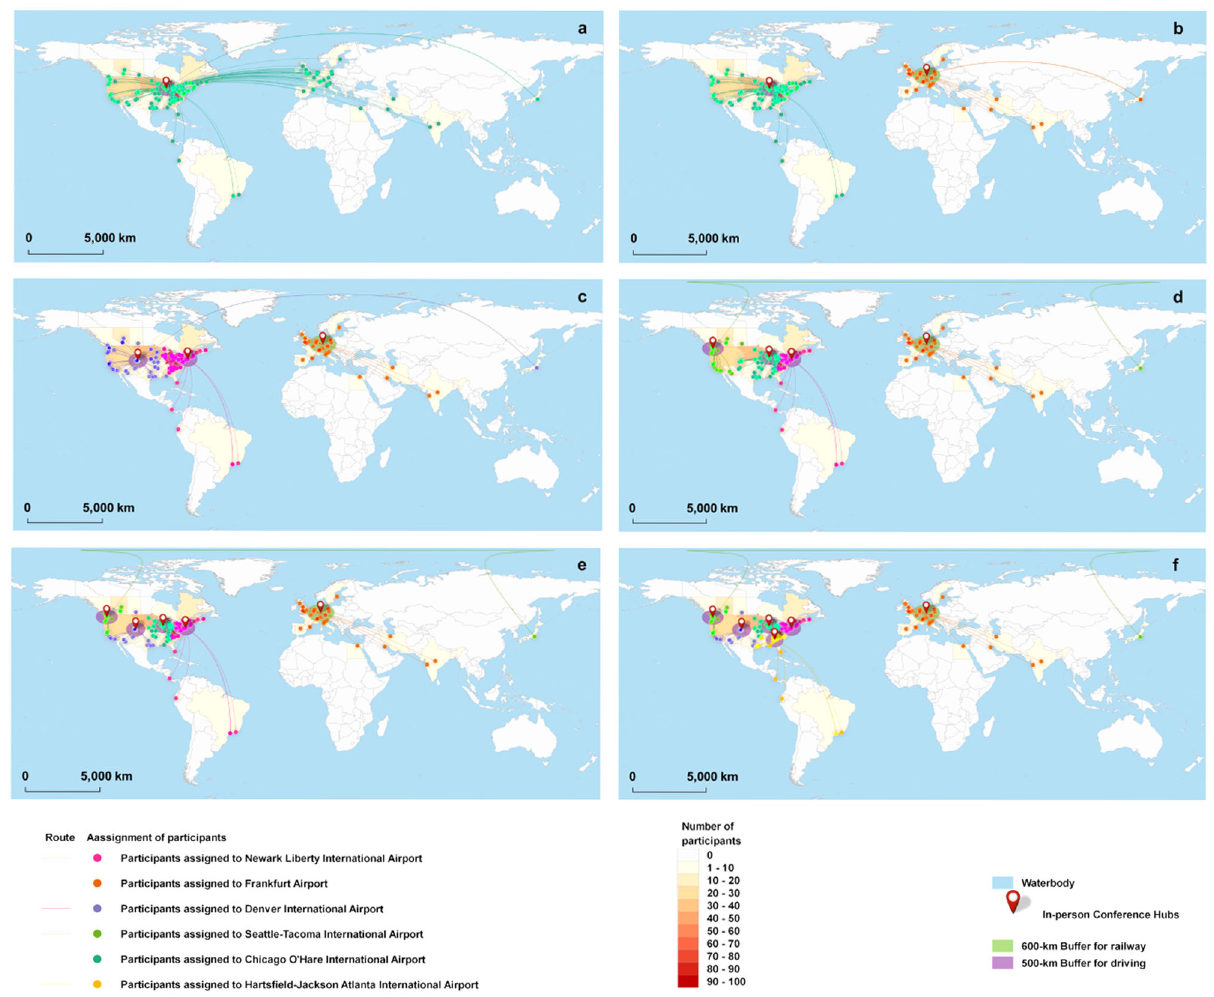
Fig. 3 Map of transportation routes and hub decisions for in-person scenarios. a 1-hub in-person conference. b 2-hub in-person conference. c 3-hub in- person conference. d 4-hub in-person conference. e 5-hub in-person conference. f 6-hub in-person conference. Dots represent the origins of participants, and lines represent the route from their origins to their assigned conference hubs. Their colors indicate the assignments of participants to the conference hubs. Color scale shows the number of participants in each region around the world. These regions are divided according to the regional datasets for electricity production in Ecoinvent 39